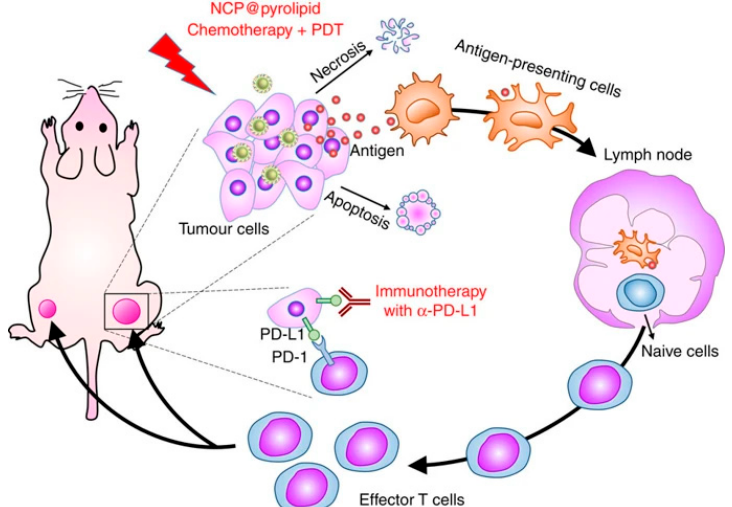
Figure 5. Chemotherapeutic agent and PDT of NCP@pyrolipid induced ICD, which caused the release NCP@pyrolipid chemotherapy/PDT significantly stimulated the generation of tumor-specific